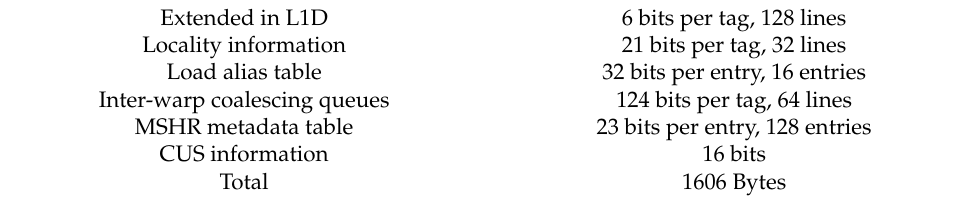
Table 4. Hardware